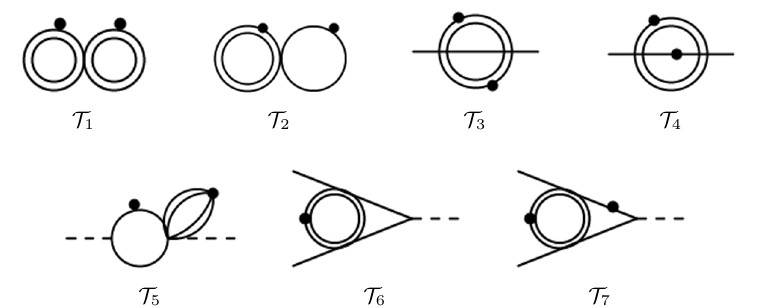
Figure 26. The master integral topologies T 1 ... 7 for fermionic loop induced NNLO vertex correction. The solid single line represents a propagator with mass m and the double line represents a propagator 1 with mass m , while the dashed line represents a massless propagator with momentum squared 2 equal to t . The dots represent additional powers of the